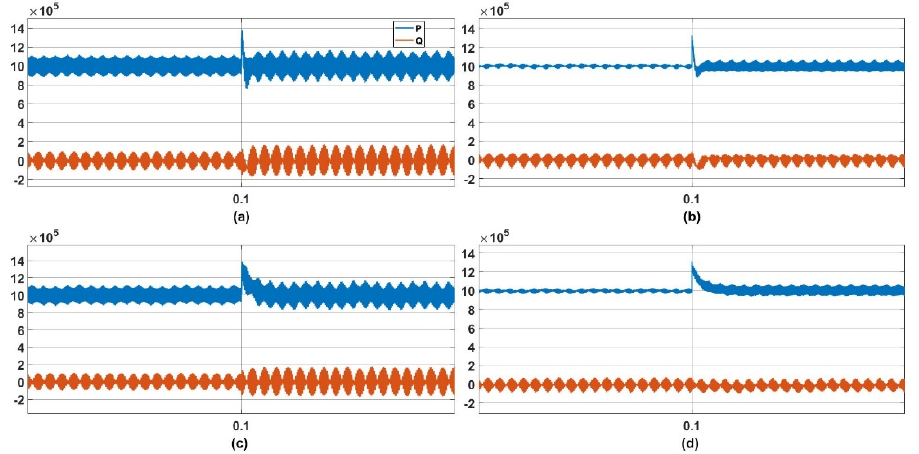
Figure 21. Power flow in a balanced voltage swell in the case of ( a ) 2L- αβ , ( b ) 3L- αβ , ( c ) 2L-dq and ( d ) 3L-dq .